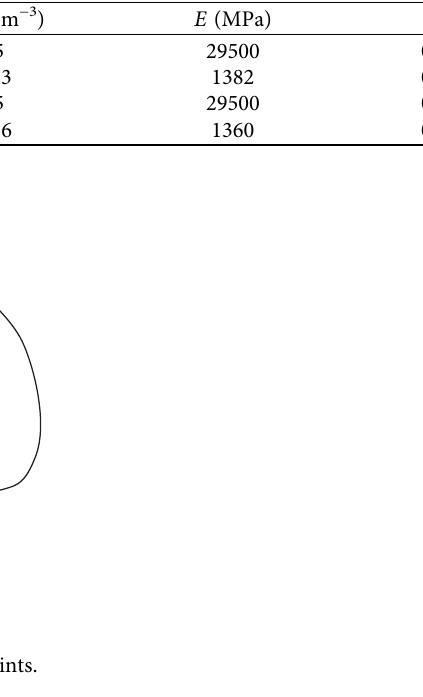
Table 3: Physical and mechanical parameters of the lining.